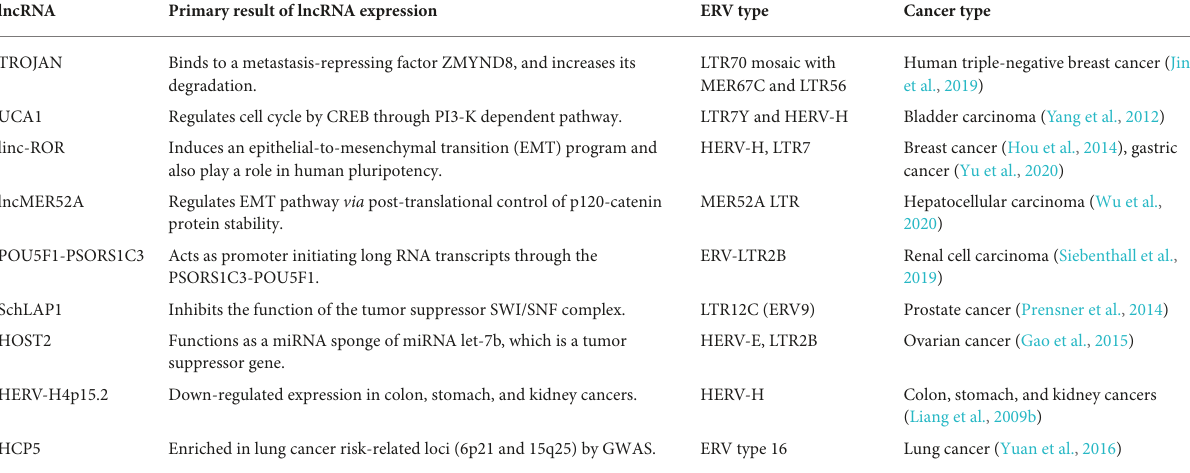
TABLE 3 HERV-derived lncRNAs with oncogenic